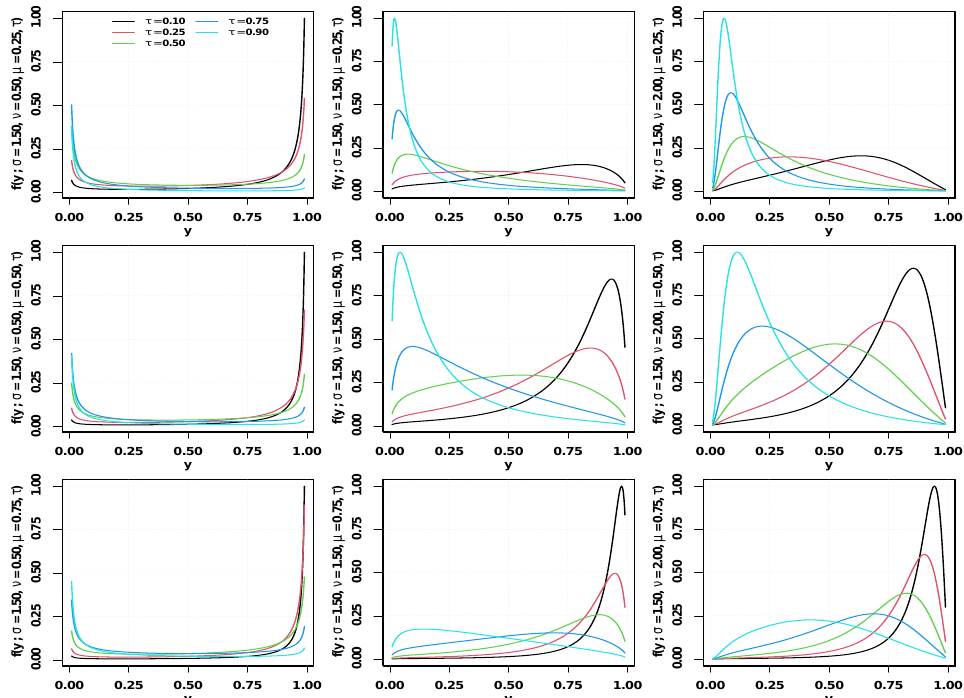
Figure 3. Plots of the UWMOQ PDF for the indicated values of µ , ν , τ , and σ = ς =